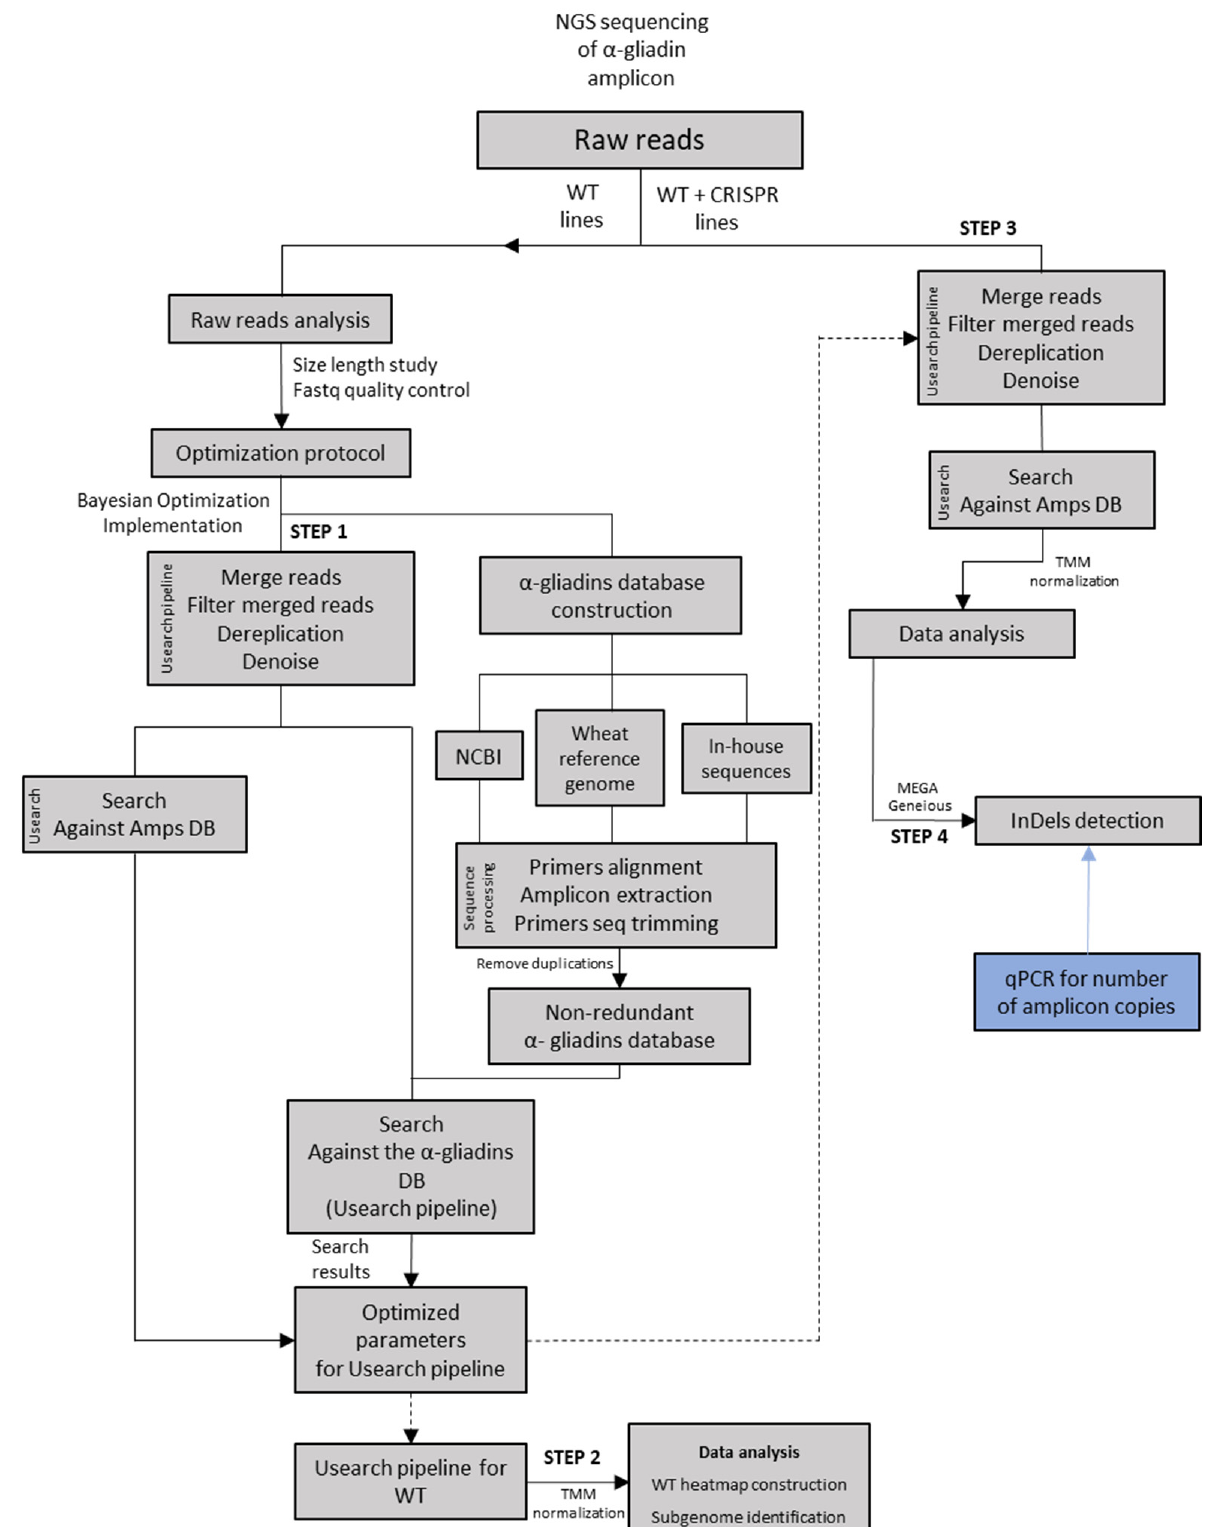
Figure 5. Pipeline for InDel analysis in edited amplicons of CRISPR lines, including prior optimization steps. Steps 1–4 can be found in CRISPR analysis repository: https://github.com/LabFBARRO/CRISPRanalysis, accessed on 10 September 2021. WT: wild type; Amps: unique denoised α -gliadin amplicons. Dashed lines indicate steps in which optimized parameters were used.